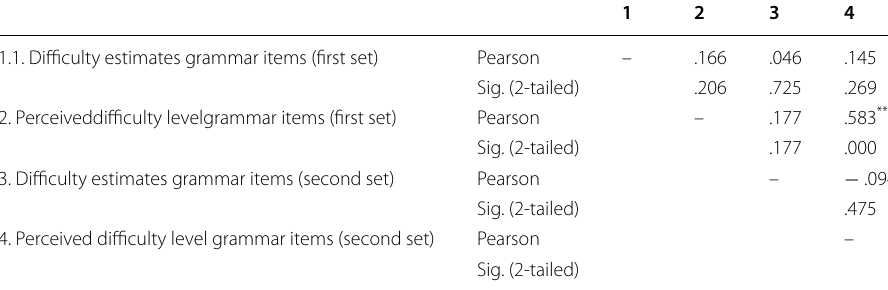
Table 1 Pearson’s product moment correlation of difficulty estimates and perceived difficulty level (grammar items)